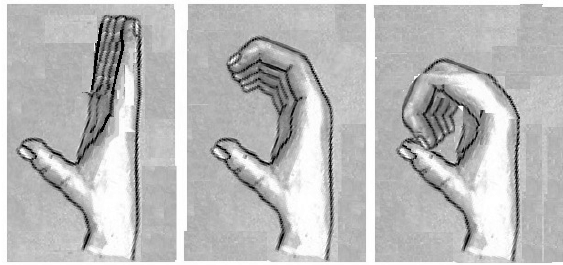
Fig. 12. Illustration of the three positions of the fingers of the